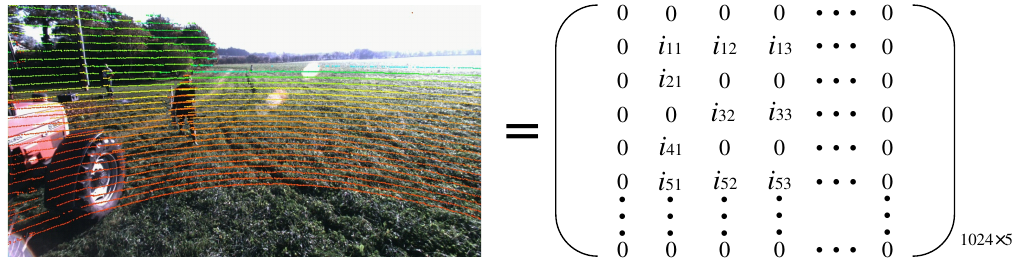
Figure 10. Projection of associated LiDAR points on the image plane. Projected points on the image plane are interpreted within a sparse matrix which presents the depth of each pixel